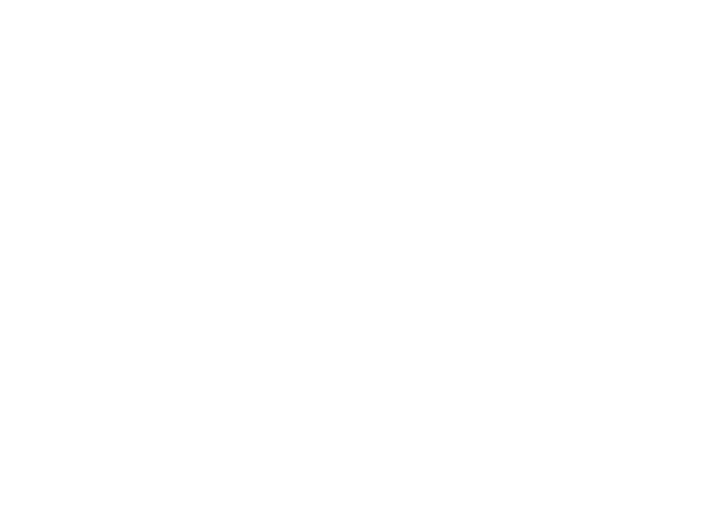
Figure 4. The Focal Transformer block. FSA is the focal − based self − attention module. LN is the layer normalization layer. MLP is the multi-layer perception network.